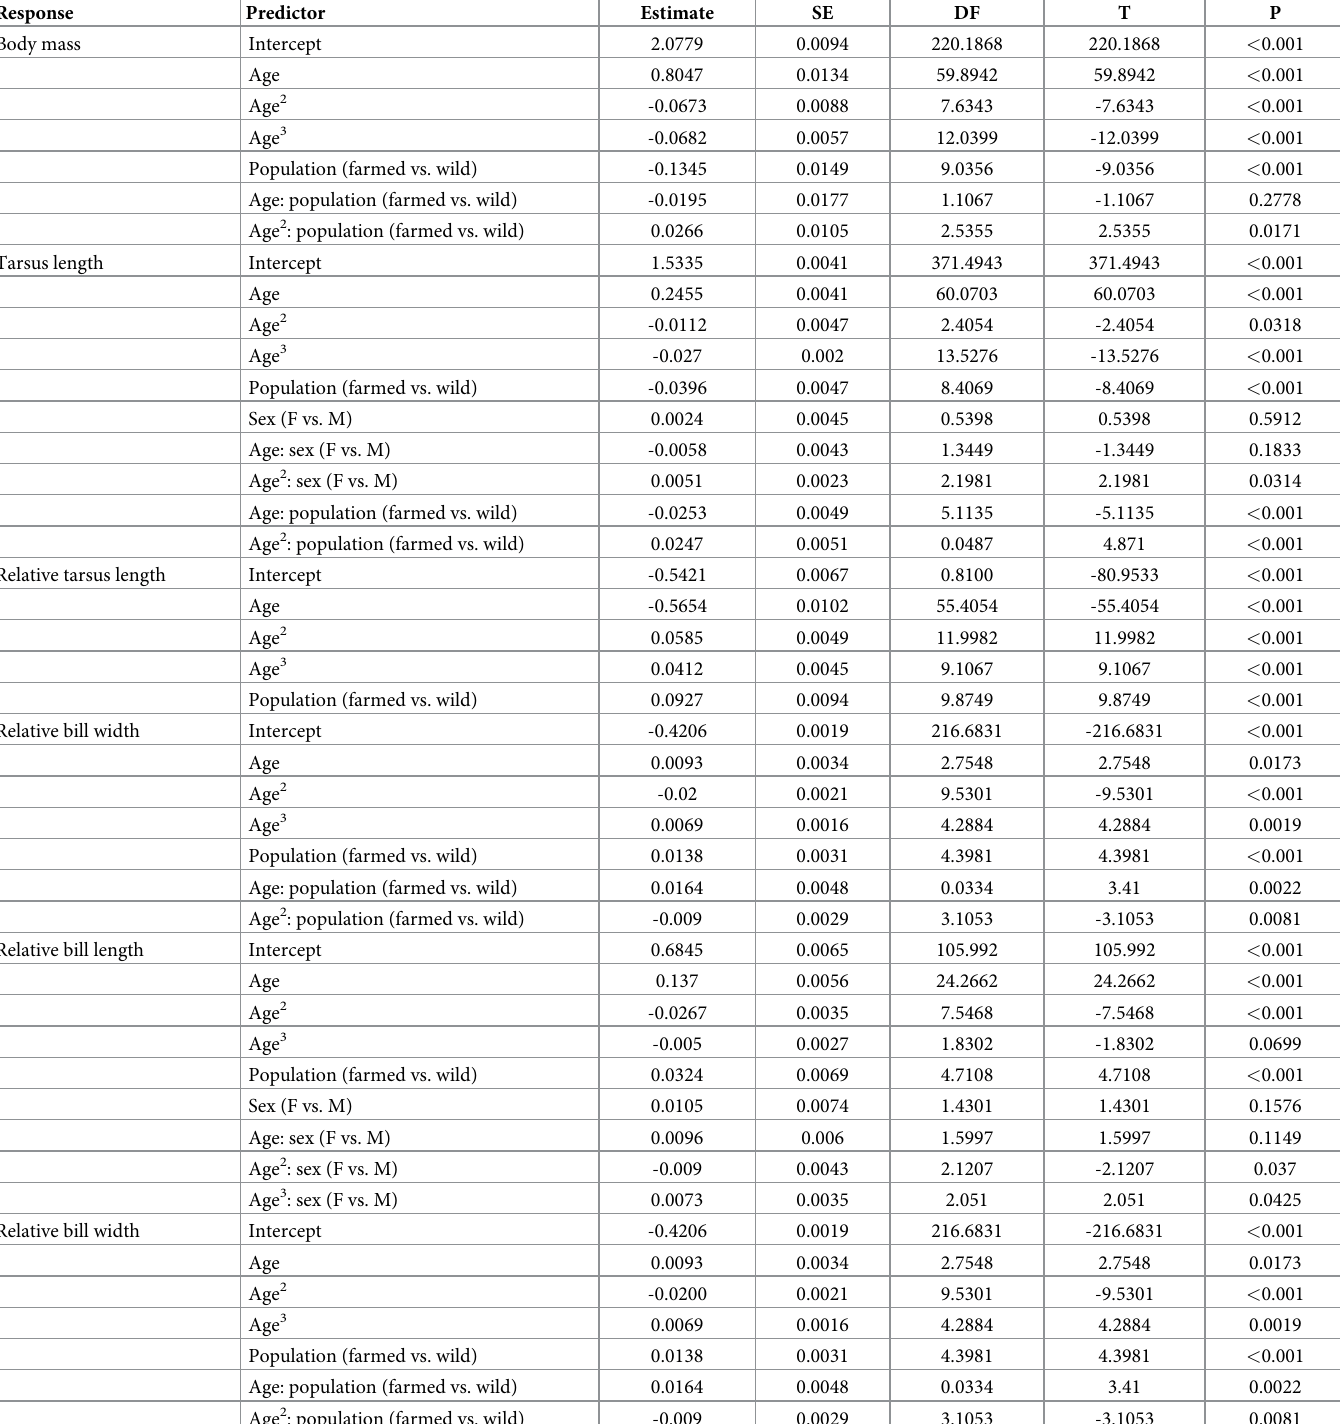
Table 1. Parameter estimates for minimal adequate models describing variation of five morphometric parameters: Body mass, tarsus length, structural body size (i.e. relative tarsus length), relative bill length and relative bill width (n wild = 24, n farmed = 40).